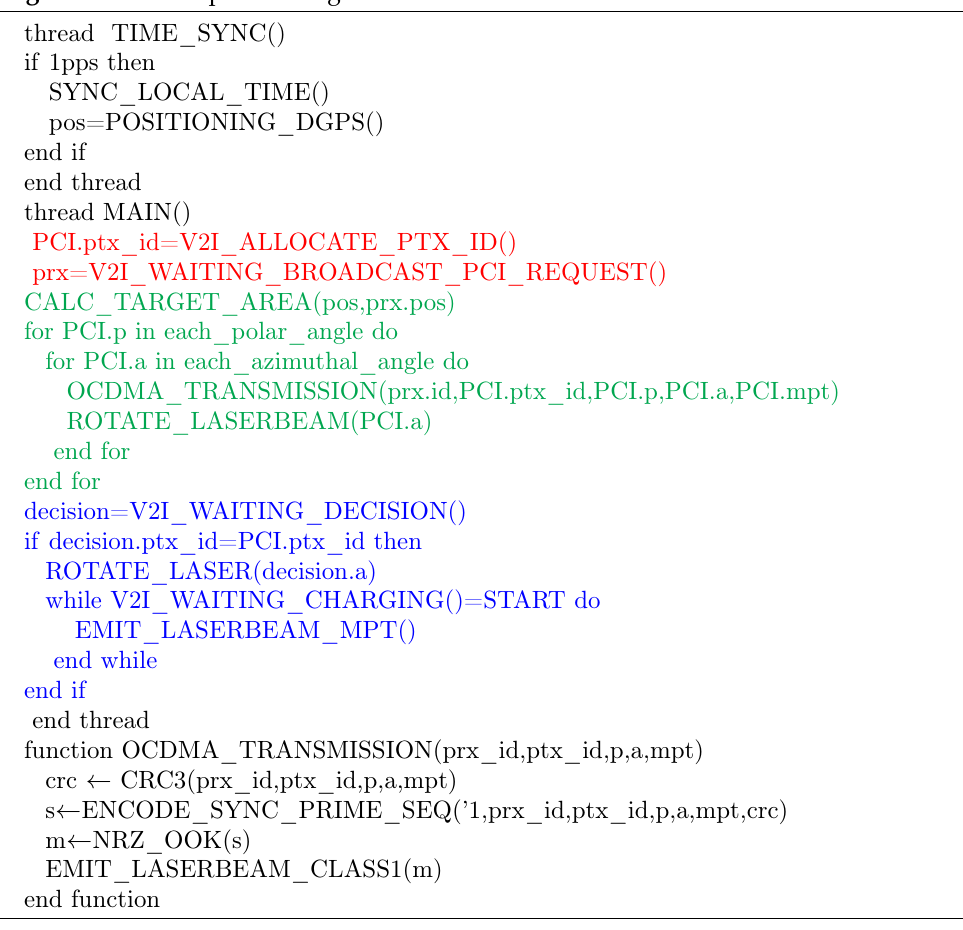
Algorithm 1 PTX operation